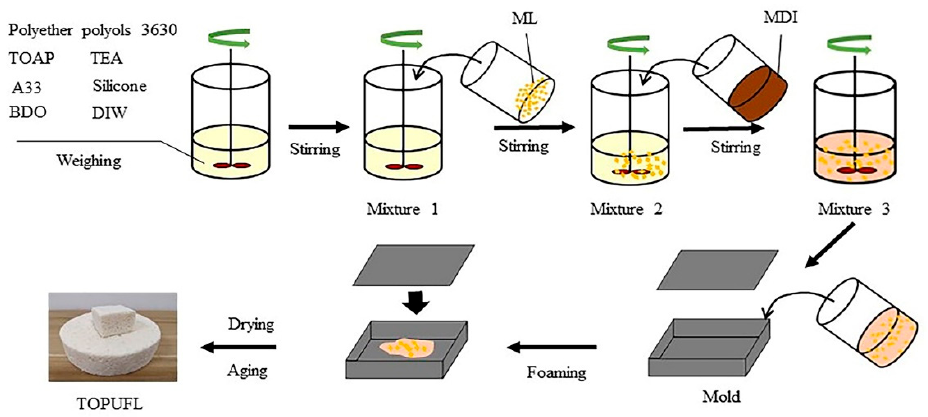
Figure 2. The synthesis process of TOPUFL. Table 2. Foam formulation and design.